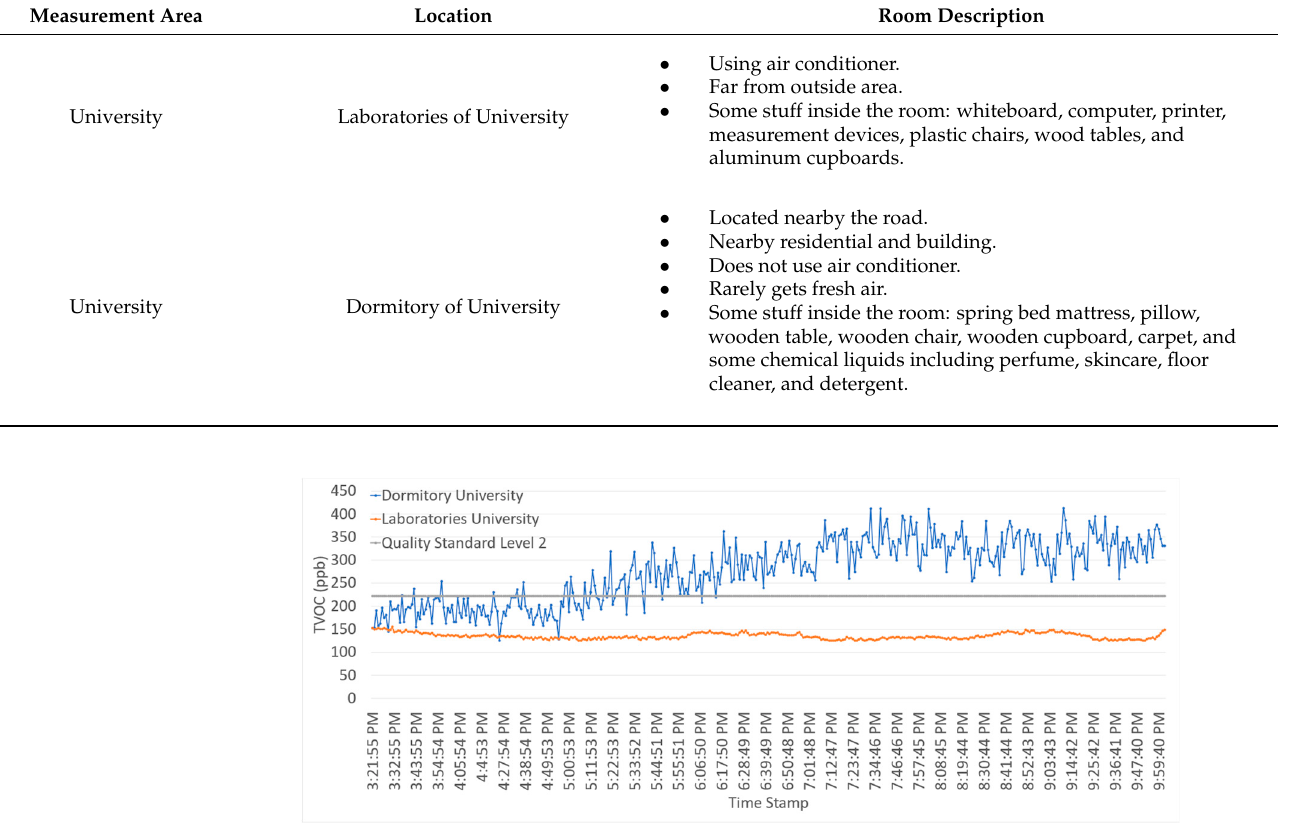
Table 8. The main characteristics of the measurement area.